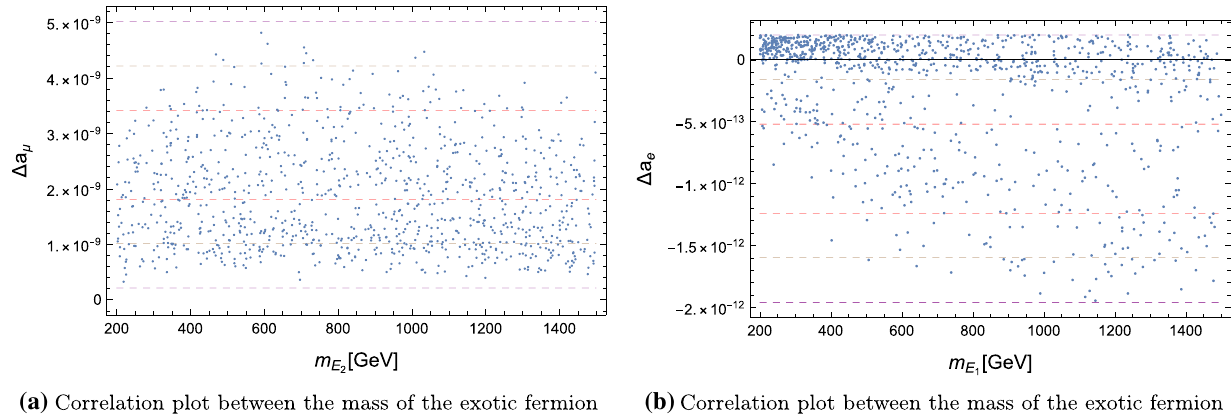
Fig. 2 Correlation plots of the (cid:12) a μ, e and the mass of the exotic fermion m E